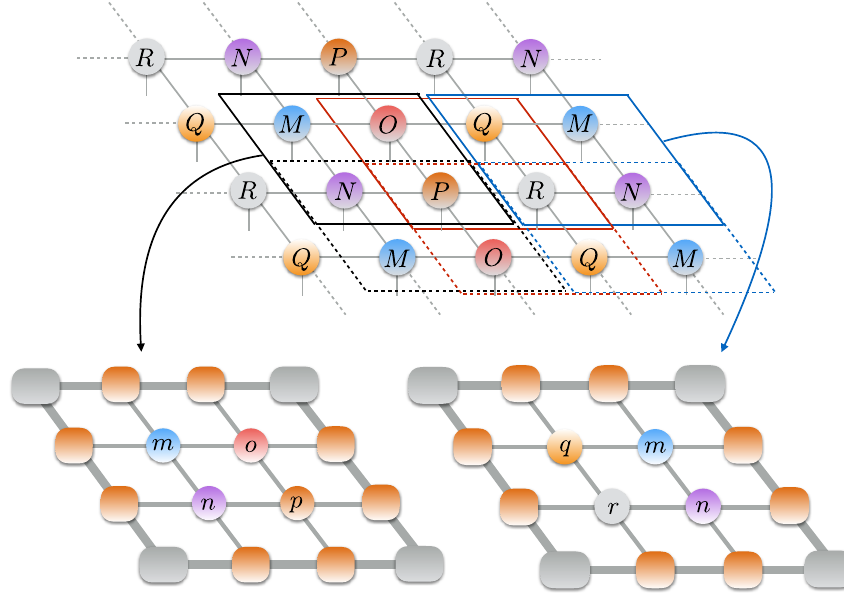
Figure 3: A unit cell of size 3 × 2 consists of six different M tensors (here denoted M , N , O , P , Q , and R ). For each of the six relative coordinates in the unit cell, we have to obtain a 2 × 2 CTM representation (indicated by the solid and dashed squares,